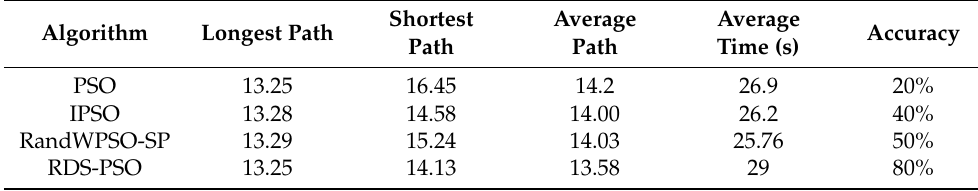
Figure 8. Iteration of three algorithms. Table 2. Comparison of algorithm